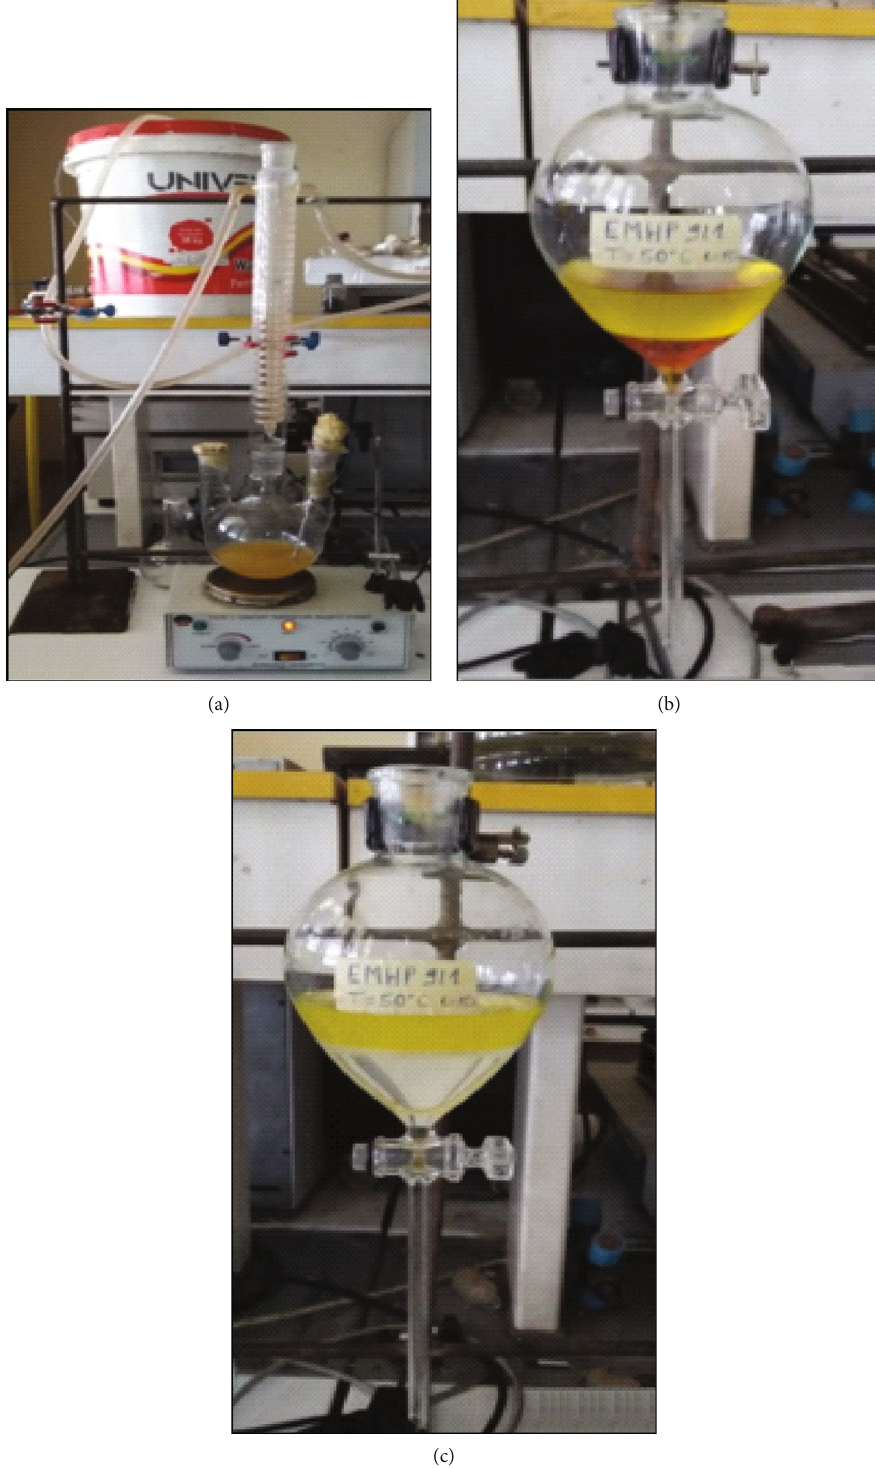
Figure 3: Steps of (a) reaction, (b) settling, and (c) washing the